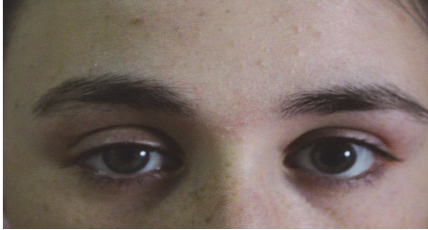
Figure 1: Myosis and eyelid ptosis were noted on the right